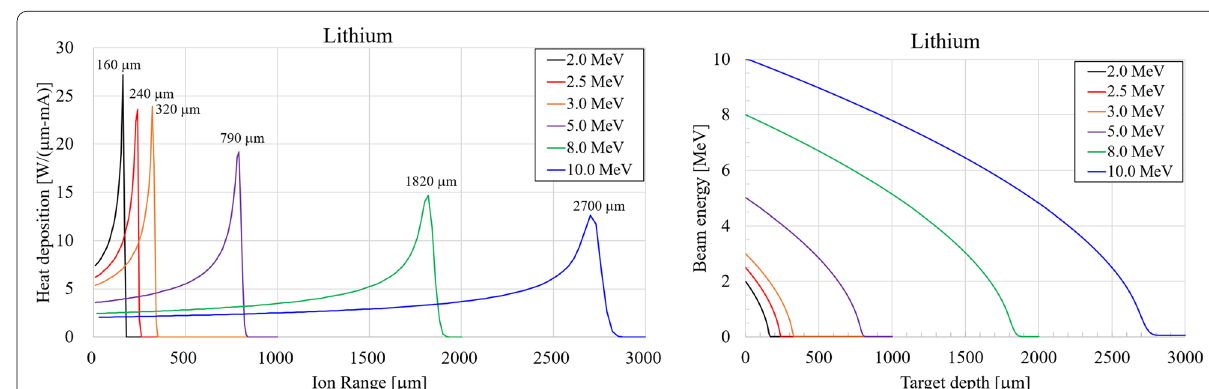
Fig. 5 (Left) Heat deposition profile for lithium targets at various incident proton beam energies. The numbers on the peak position of each profile give the Bragg peak position. (Right) The remaining beam energy at each target